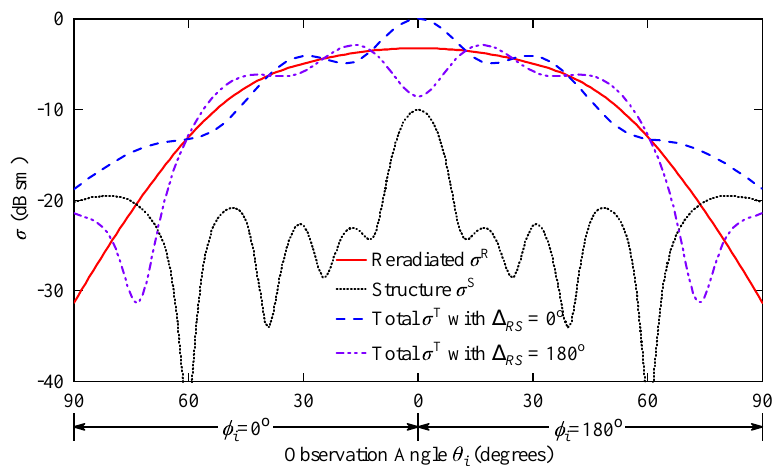
Figure 20. The monostatic RCSs based on the reradiated, scattered, and the total fields when the phase difference ( ∆ RS ) between E R and E S is 0 ◦ and 180 ◦ .